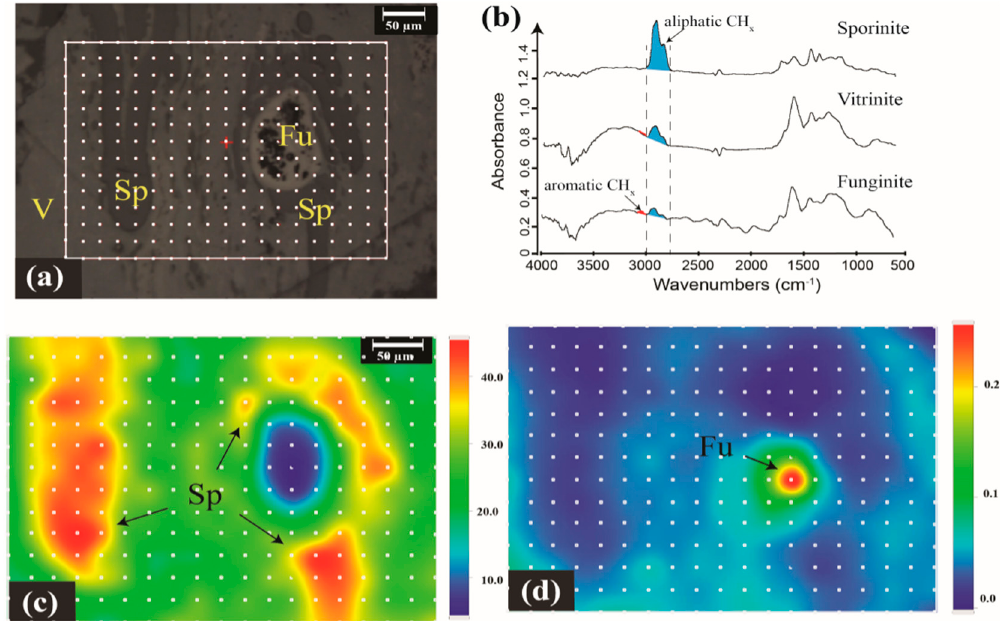
Figure 4. Chemical maps of a microscopic field with distinct sporinite (Sp), funginite (Fu), and vitrinite (V). ( a ) Photomicrograph in reflected light showing mapping sequence, indicated by yellow dots; ( b ) Representative FTIR spectra of sporinite, vitrinite, and funginite. The blue-filled areas represent the absorbance values that are mapped in panel ( c ); the ratios of red- over blue-filled areas are mapped in panel ( d ); ( c ) Chemical mapping of integrated peak of aliphatic CH x groups (3000–2800 cm − 1 region); ( d ) Map of the ratio of the integrated areas between 3100–3000 cm − 1 and 3000–2800 cm − 1 ( i.e. , a proxy of aromaticity); Units in panels c and d are arbitrary absorbance units. Modified after figure 8 in Chen et al. [26] with copyright permission from Elsevier.